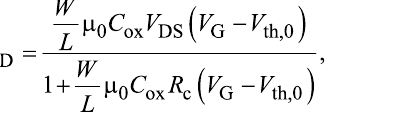
Figure 4: (a) Linear scale plot of I D (left axis) and of the transconduc- tance g m (right axis) at V DS = 0.1 V and T = 298 K. The extraction of the field effect mobility ( μ lin ) from the maximum of g m and of V th by the linear extrapolation method ( V th,lin ) is illustrated. (b) Plot of I D / g m1/2 vs V G with illustration of extraction of the mobility ( μ 0 ) and threshold voltage value ( V th,0 ) corrected by the effect of the contact resistance ( R C ).